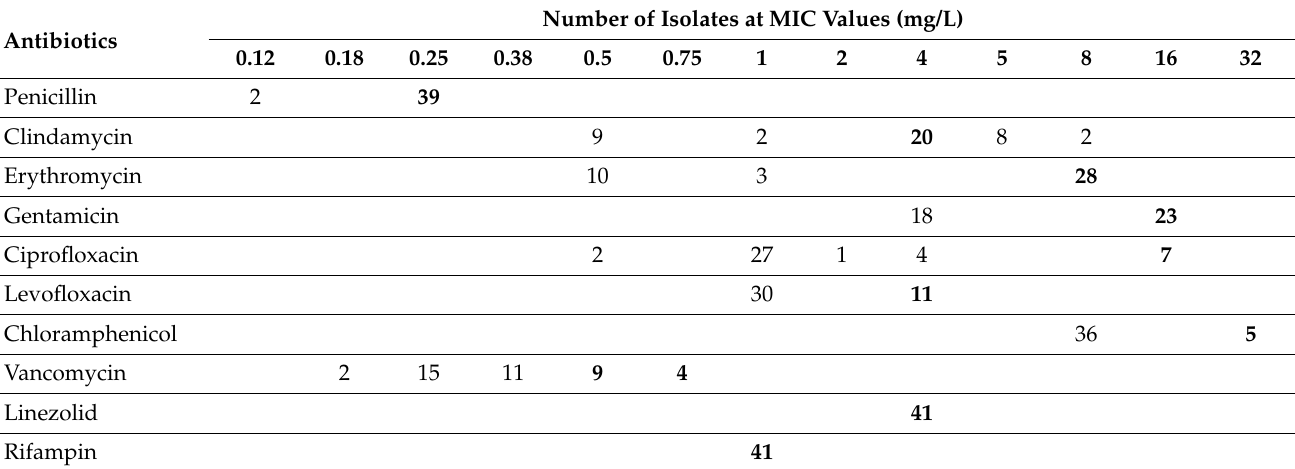
Table 3. MIC distribution of antibiotics for isolated S. aureus (n =